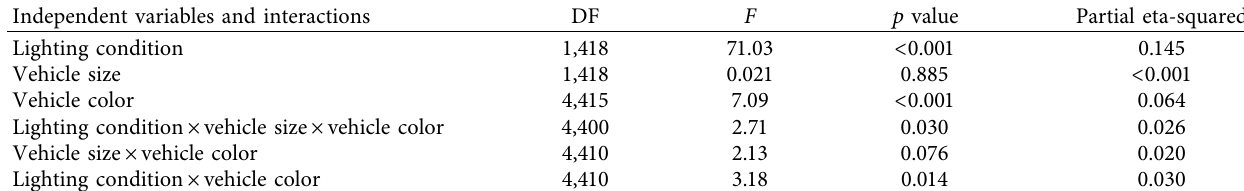
Table 7: Main and interaction effects under the rear identification scenario.